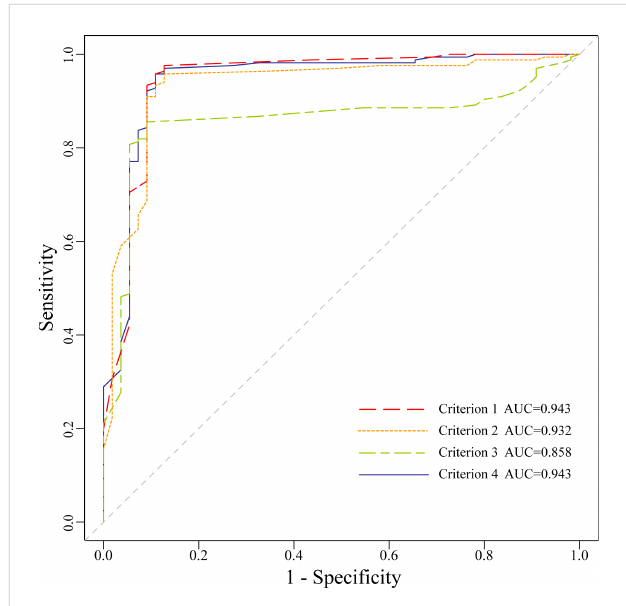
FIGURE 3 The Receiver operating characteristic curves of malignant risk score for the four